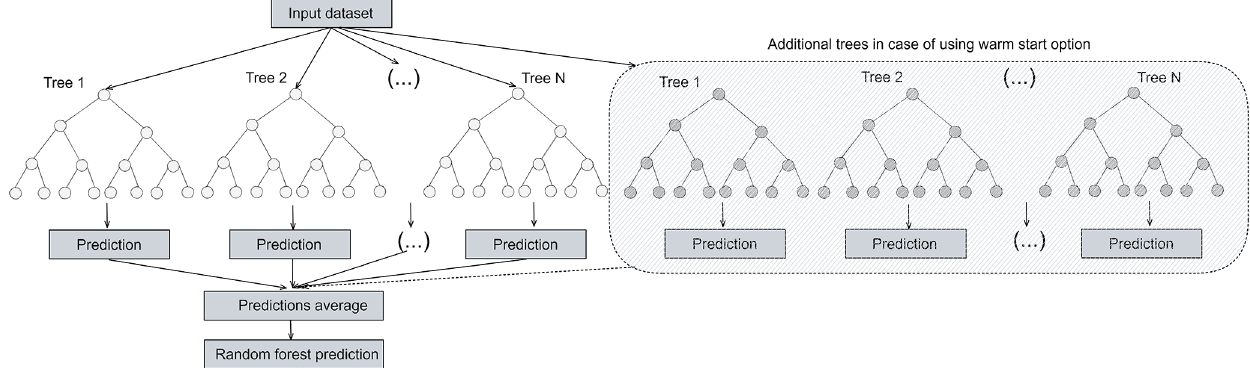
Figure 3. Schematic diagram of the random forest algorithm and the additional trees that are added to the model in the case of a warm start. The additional trees are trained using the new training data, while the old trees (from the pre-trained model) remain